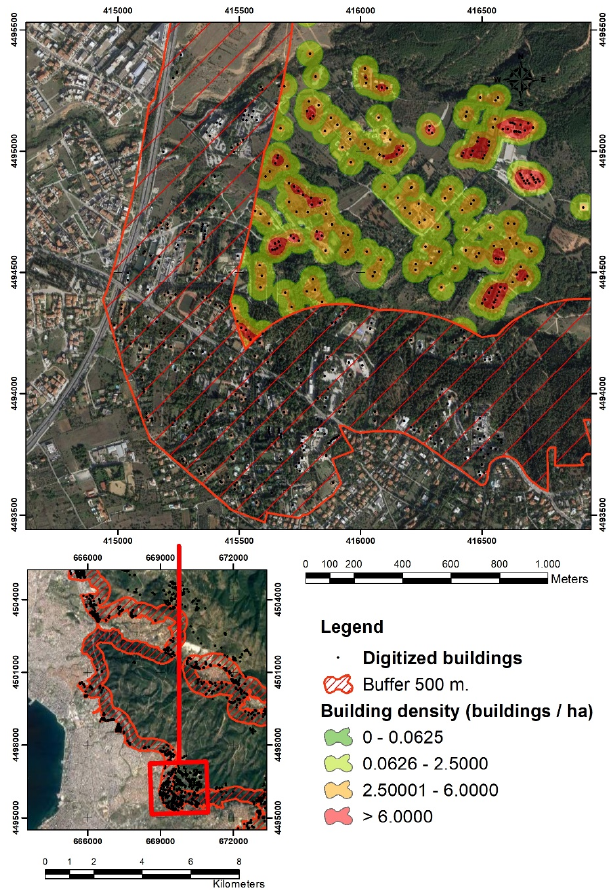
Figure 3. Building density surface has been produced for WUI category II. Classes with a density over 0.0625 (or 1 building/16 ha) and outside the buffer zone of 500 m represent WUI category II.